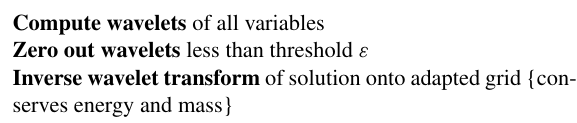
Algorithm 1 Complete WAVETRISK - OCEAN time-stepping